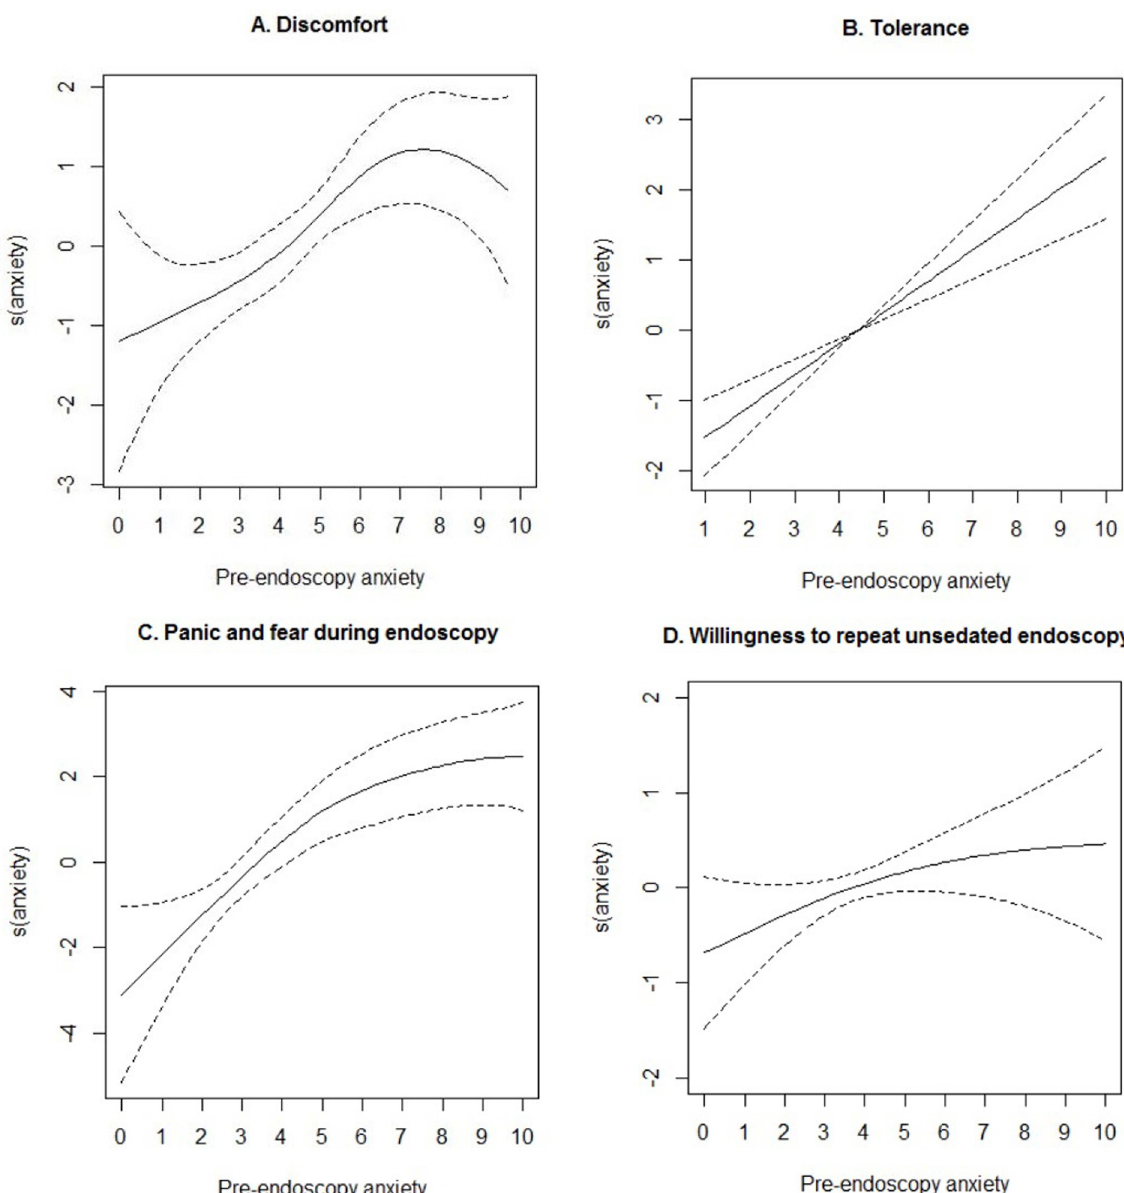
Fig 1. Non-linear associations between pre-endoscopy anxiety with patient-related outcomes. The results were based on general additive model taking pre-endoscopy anxiety score as the smoothing term. The figures showed the smooth component (pre-endoscopy anxiety) of fitted general additive models in terms of discomfort (Panel A), tolerance (Panel B), panic and fear during endoscopy (Panel C), and the willingness to repeat unsedated endoscopy (Panel D). A larger s (anxiety) value indicated greater discomfort, lower tolerance, greater panic and fear during endoscopy, and lower willingness to repeat unsedated